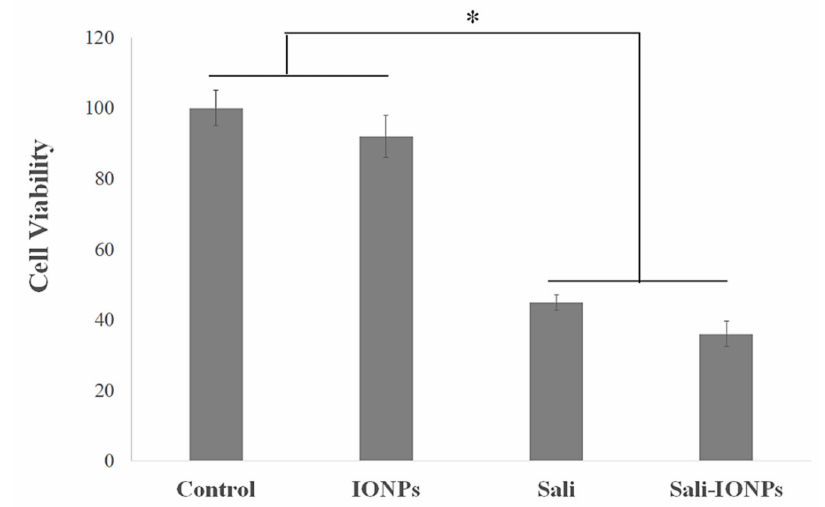
Figure 5. Cytotoxicity evaluation of salinomycin and Sali-IONPs on U251 after 48 h treatment. Note: * indicates a significant di ff erence compared to the control group at p < 0.05. Data was presented as mean ± SD; n =